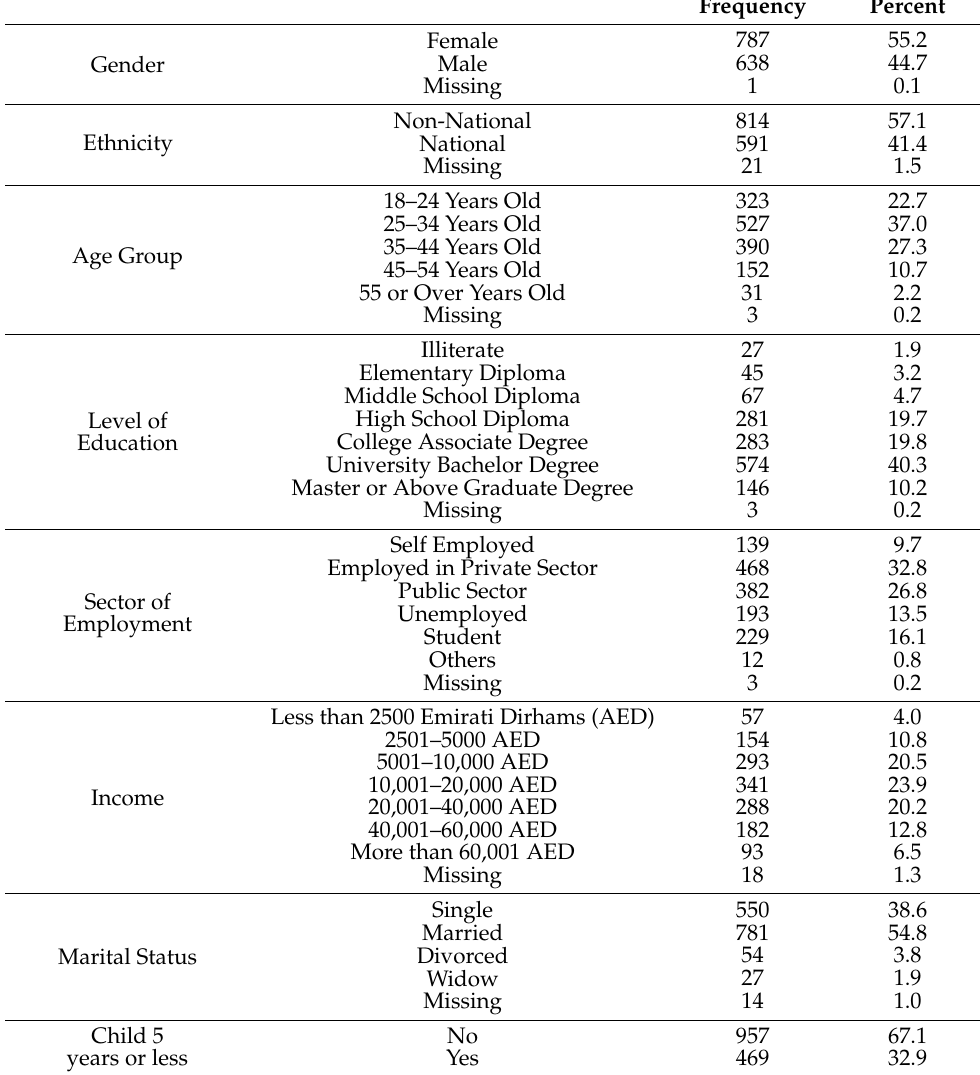
Table 3. Demographic characteristics of sample